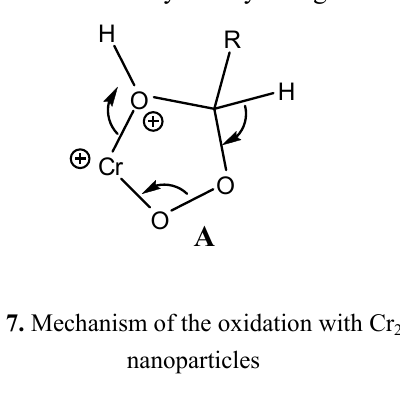
Fig. 7. Mechanism of the oxidation with Cr